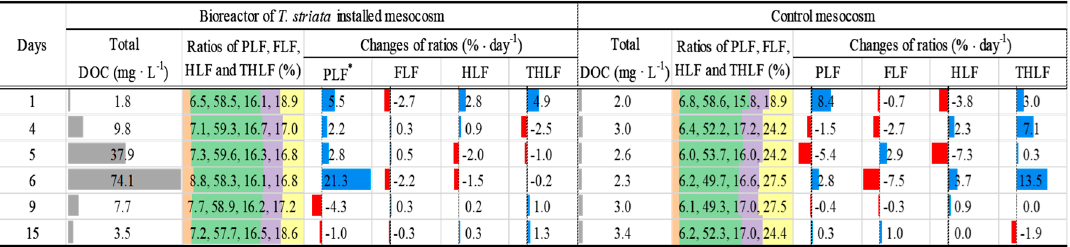
Figure 7. Total concentrations of dissolved organic carbon (DOC) and relative ratios of four fractions of DOC (PLF, FLF, HLF and THLF), and its changes of each day in bio-reactor installed mesocosm and control mesocosm. Grey bars indicate the relative DOC concentrations, each ratio of orange, green, violet and yellow bar indicates the ratios of four fractions, respectively, and changed amounts of ratio of each four DOC fractions are indicated as blue (plus) and red (minus) bars, respectively.